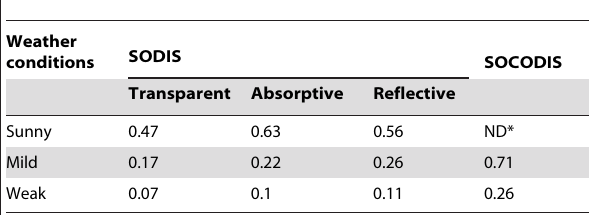
Table 2. Comparison of k max (1/min) for P. aeruginosa disinfection between SODIS and SOCODIS system under different weather conditions (Rainwater with low turbidity (2- 5NTU) and neutral pH values).